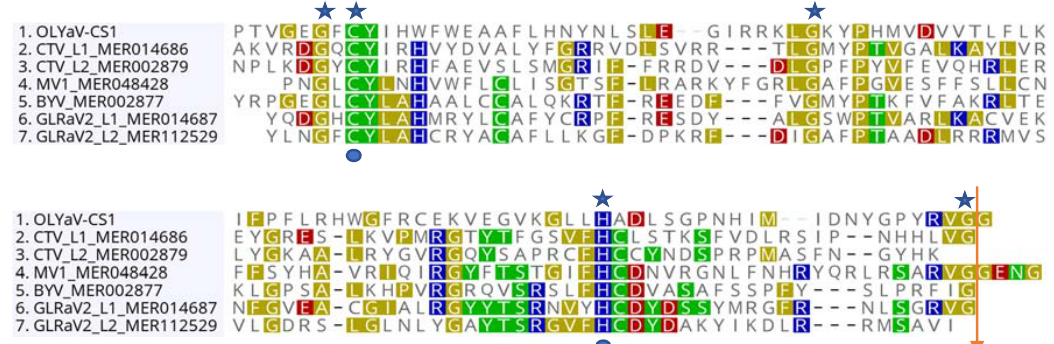
Figure 3. Alignment of the C-terminal region of papain-like leader proteases from different members of the Closteroviridae family. CTV: citrus tristeza virus; MV1: mint virus 1; BYV: beet yellows virus; GLRaV2: grapevine leafroll associated virus 2. Invariant residues are labelled with a blue star above the alignment. The predicted catalytic cysteine and histidine residues are labelled with a blue circle below the alignment. The orange arrow indicates the proposed cleavage site.